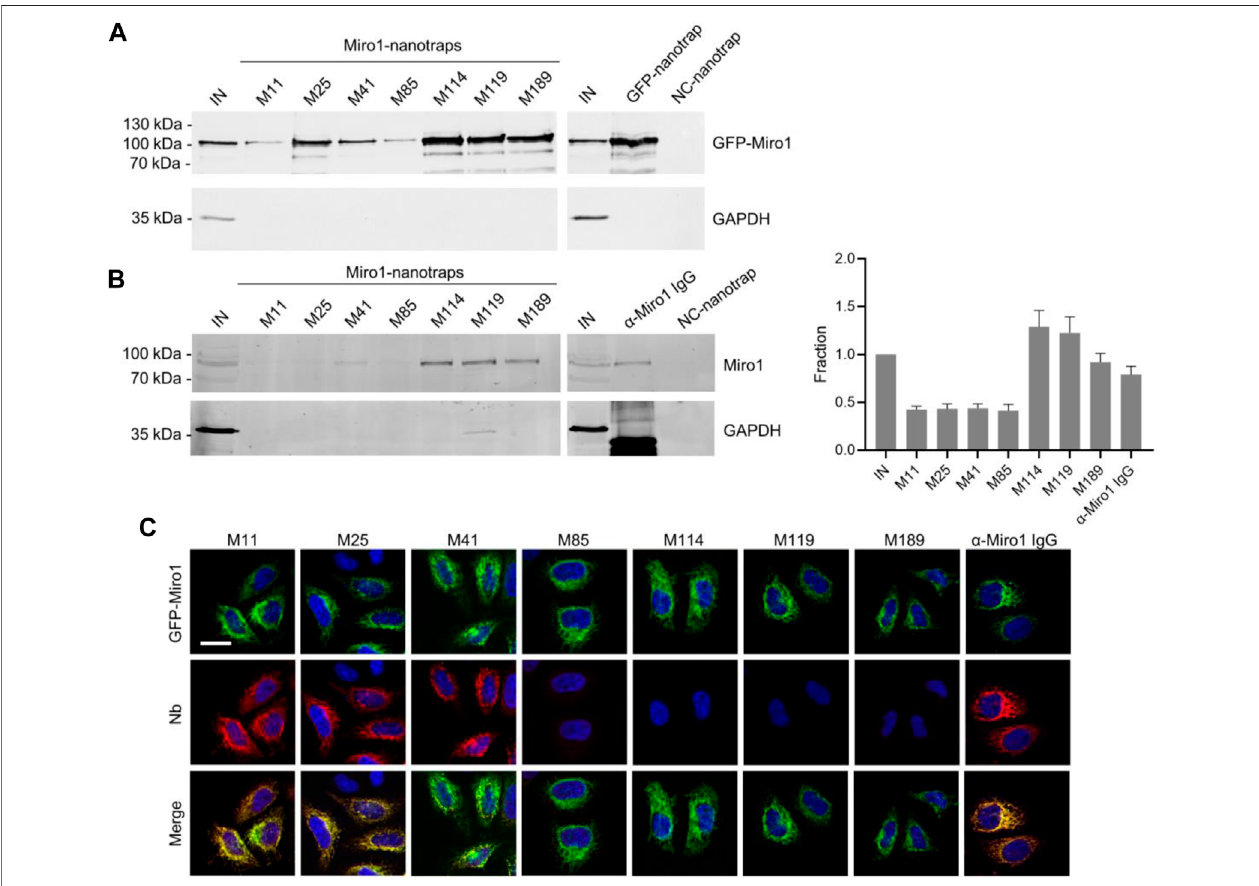
FIGURE 2 | Immunoprecipitation of Miro1 with Nbs. (A) For immunoprecipitation with immobilized Nbs (nanotraps), soluble protein fraction of HEK293 cells transientlyexpressingGFP-Miro1orGFPascontrol,wasadjustedto2 mg/mlandincubatedwithequalamountsofnanotraps.Input(IN,1%oftotal)andbound(20%of total) fractions were subjected to SDS-PAGE followed by immunoblot analysis using antibodies speci fi c for GFP (upper panel) and GAPDH (lower panel). As positive control GFP-nanotrap and as negative a non-speci fi c (NC) nanotrap were used. (B) Immunoprecipitation from non-transfected HEK293 as described in (A) were performed. Input and bound fractions were analysed with an anti-Miro1 antibody. As positive control anti-Miro1 IgG immobilized on Protein A/G sepharose and as negative control a non-speci fi c (NC) nanotrap was used. For densitometric evaluation immunoblot signals of endogenous Miro1 in the corresponding bound fractions were normalized to the Miro1 signal in the input, which was set to 1. Shown are the mean signals from three independent biological replicates ±SD. (C) Immuno fl uorescence(IF)detectionofGFP-Miro1in fi xedandpermeabilizedHeLacellsafterstainingwithMiro1-Nbsasprimarylabellingprobes.Representativeconfocal laser scanning (CLSM) images are shown of each individual Nb detected with anti-VHH antibody labelled with Cy5 (middle row). As positive control, transfected cells were stained with anti-Miro1 antibody followed by detection with a Cy5-labelled secondary antibody. Nuclei were counterstained with DAPI. Scale bar 20